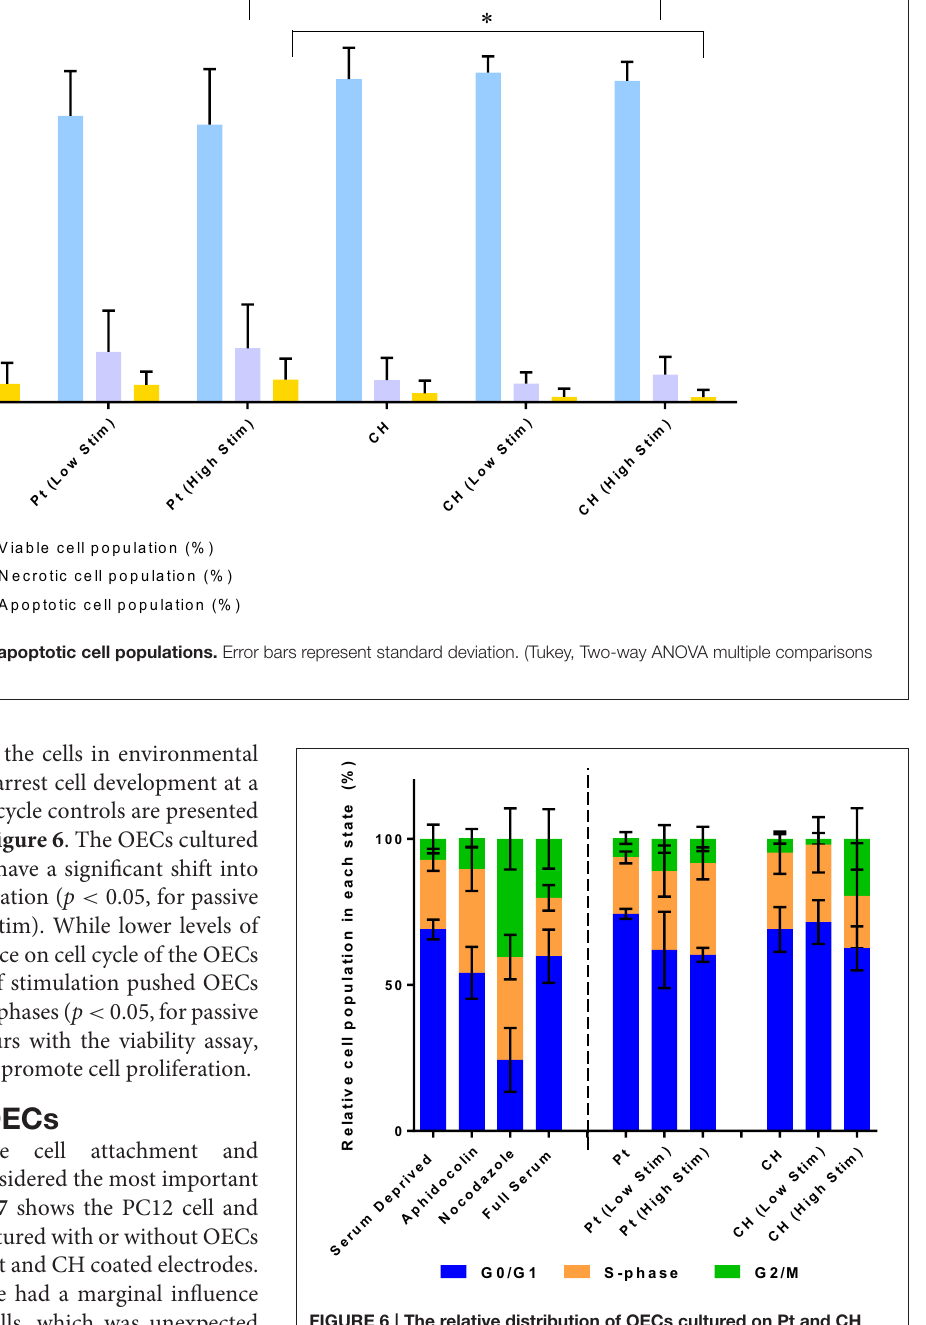
FIGURE 6 | The relative distribution of OECs cultured on Pt and CH electrodes found to be in the cell cycle phases G0/G1, S, and G2/M. Cell health controls in serum deprived media and full serum media with the addition of aphidicolin (S phase control) and nocodazole (G2/M phase control). Error bars represent the standard error of the